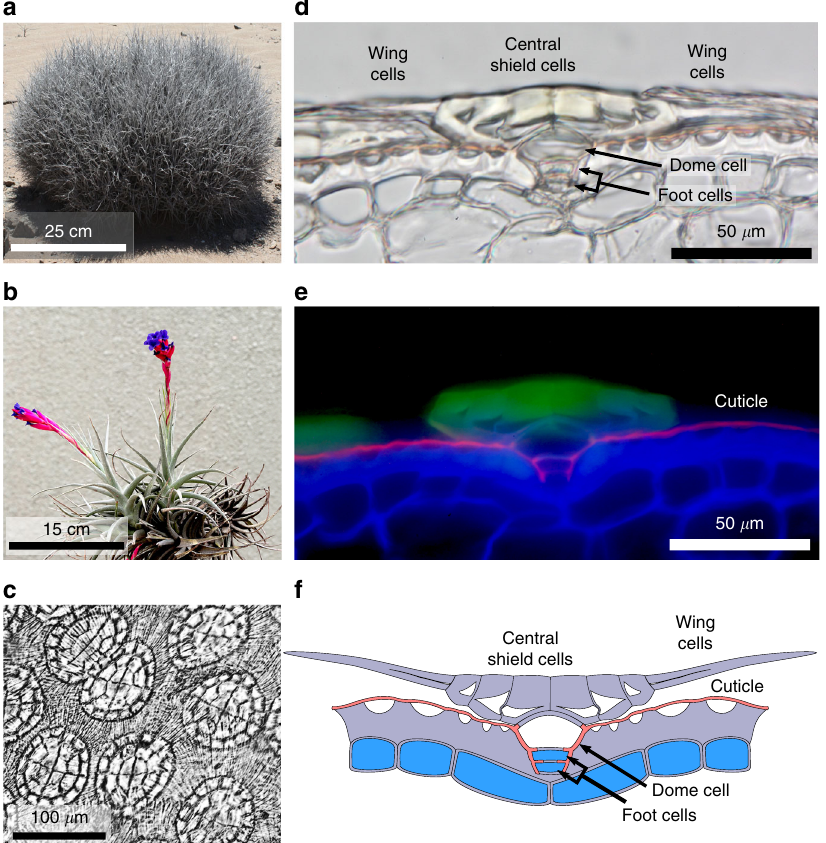
Fig. 1 Structure of the Tillandsia trichome. a Tillandsia landbeckii in the Atacama desert of Chile. b Tillandsia aeranthos , the plant studied most closely in this paper. c Surface view of the dense layer of peltate trichomes of T. aeranthos . Note the characteristic 4:8:16 organization of the central shield cells. d Transmitted light micrograph of a thin section of a T. aeranthos trichome. Note the unusually thick outer walls of the central shield cells, the thin wing cells, the dome cell, and the two foot cells connecting the trichome to the leaf mesophyll. e Composite fl uorescence image of the trichome shown in d . The cell walls of the central shield cells and epidermis are highlighted by their own auto fl uorescence (green and blue) while the cuticle is marked with Sudan 3 (fuschia). The thin wing cells are invisible because of their minimal auto fl uorescence. f Diagram of the trichome structure. Living cells are shown in blue while dead cells have their lumen shown in